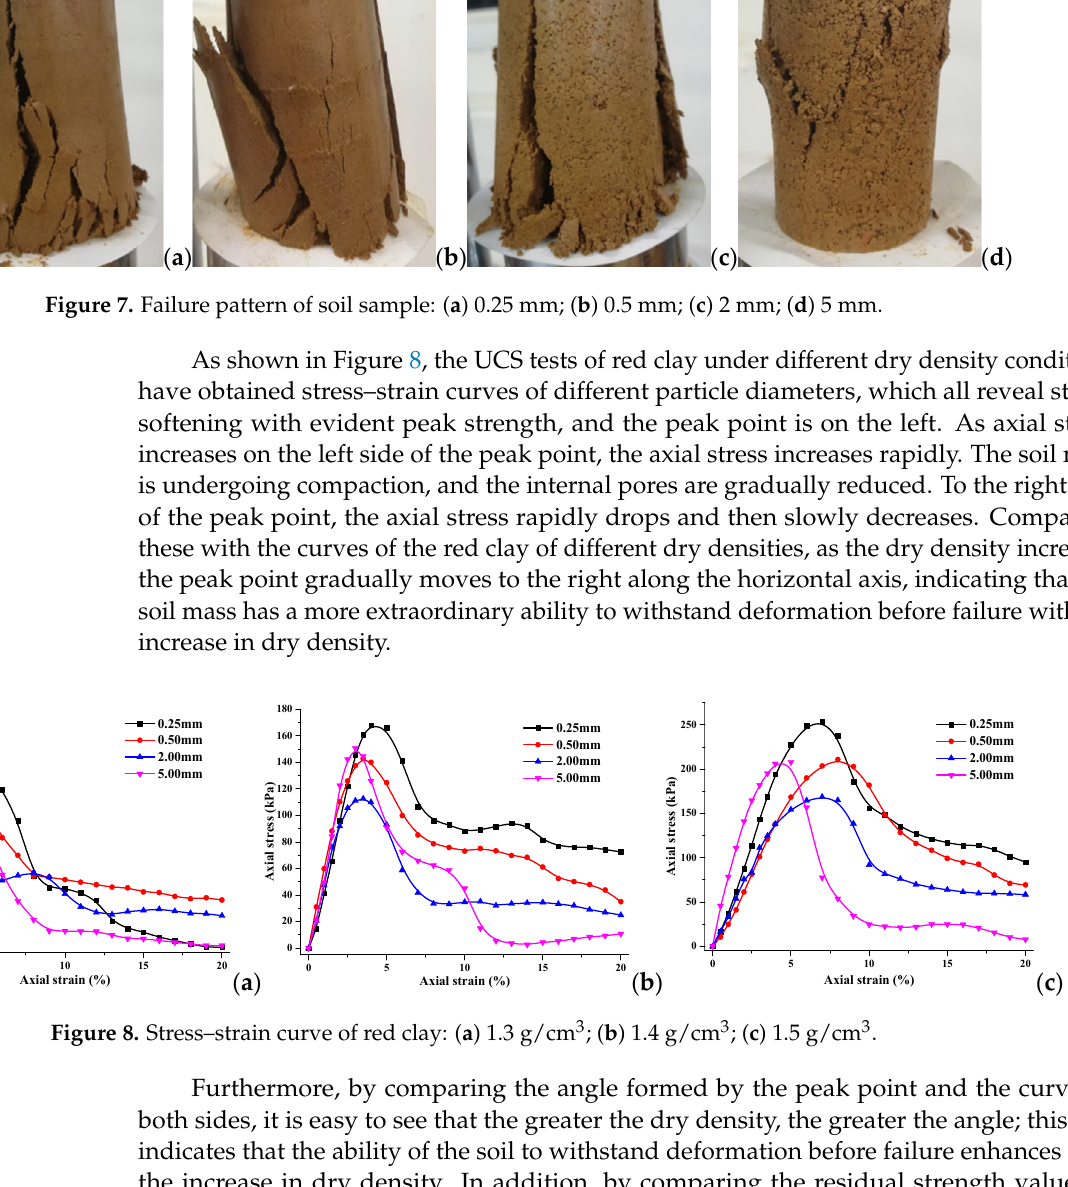
them, which causes relative slippage. As the loading pressure grows, the pores gradually connect from point to line and then to the surface, forming a shear zone and causing shear failure in the soil sample. and causing shear failure in the soil sample.